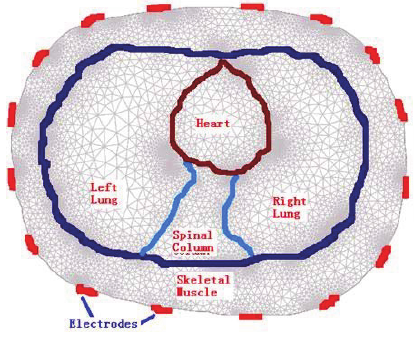
Fig. 12: Meshes refined by COMSOL based on